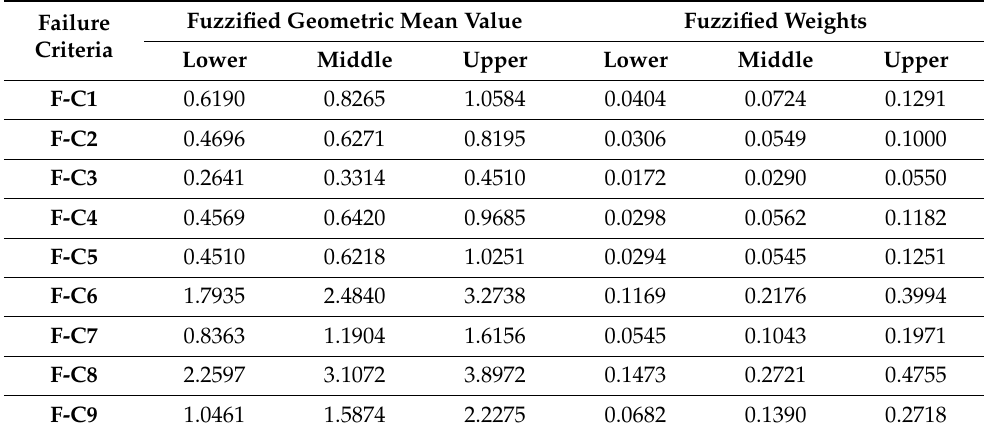
Table 10. The fuzzified weights for each criterion for lower, middle and upper